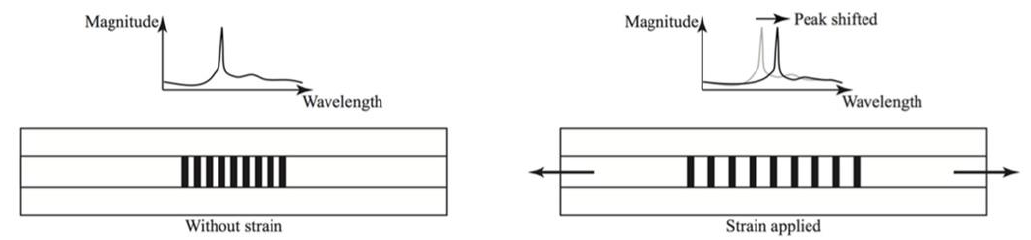
Figure 15. A schematic of the response of FBG to an applied strain. Reference [100].